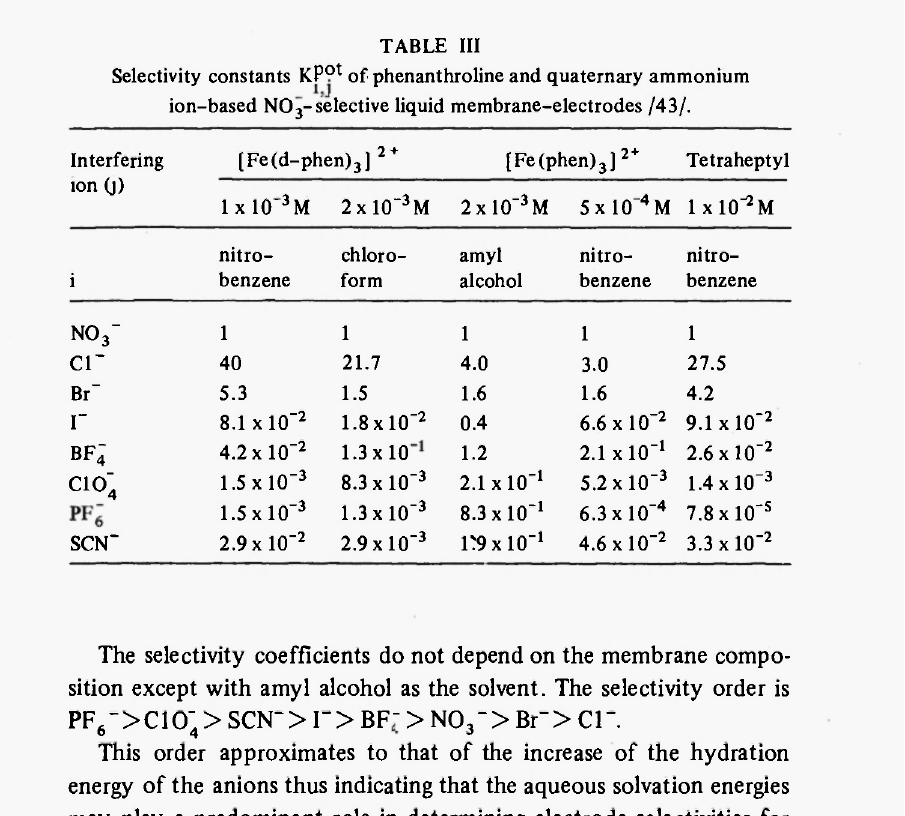
Selectivity constants KP" 1 of phenanthroline and quaternary ammonium ion-based NO3- selective liquid membrane-electrodes